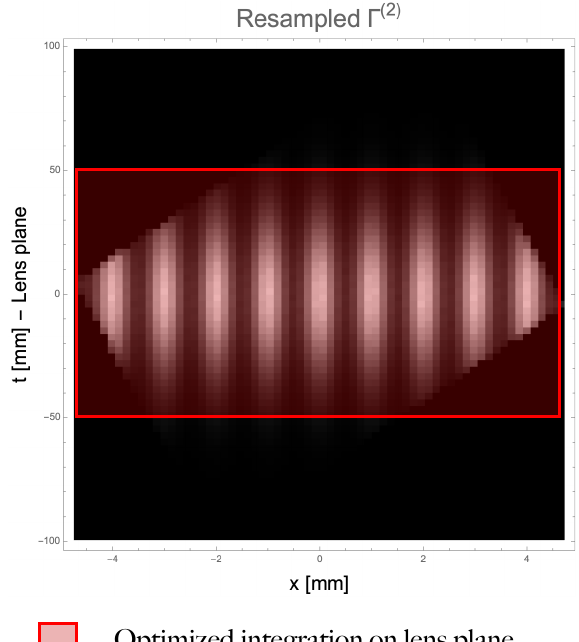
Figure 3. Resampling of the correlation function of Figure 1b on a regular grid in the ( x , t ) plane. The spacing between neighboring pixels is given by Equation (22) along the horizontal direction and (20) along the